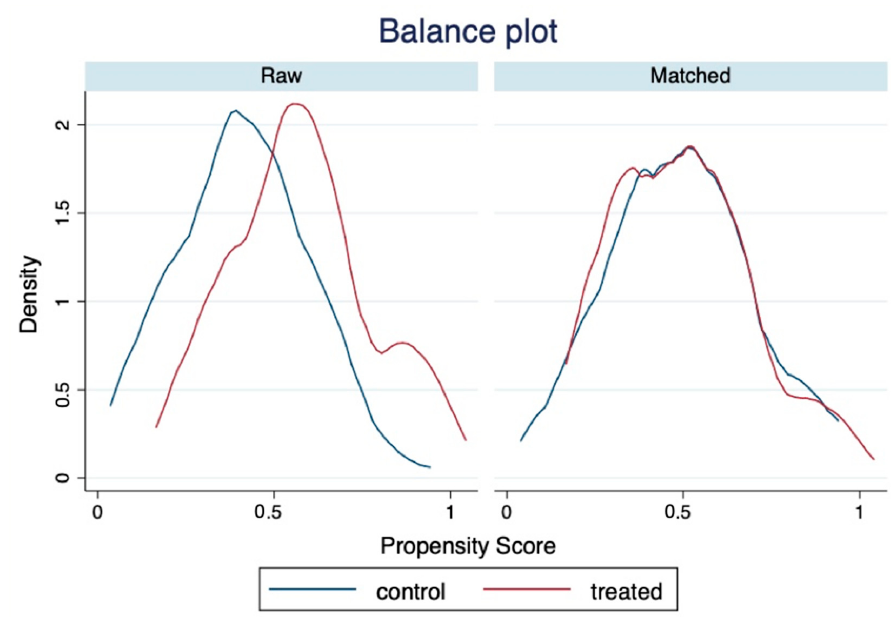
Figure 2. Balance plot of the propensity score before and after matching (created by psmtest, tbalance density command in STATA).